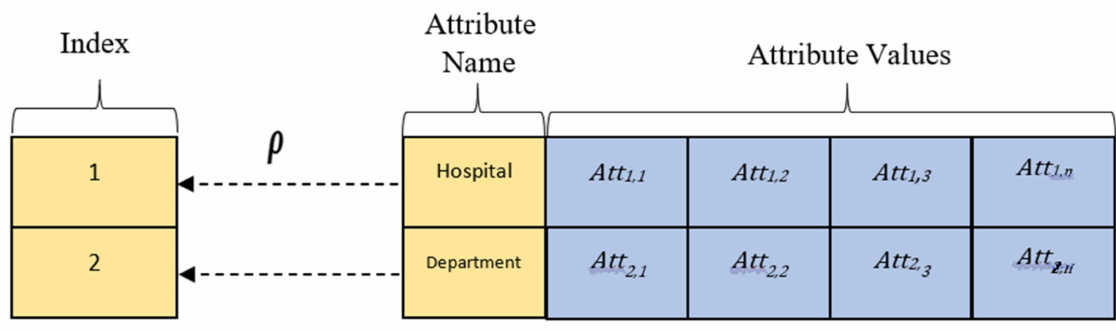
Figure 4. Example of the access. matrix Att ( x , y )